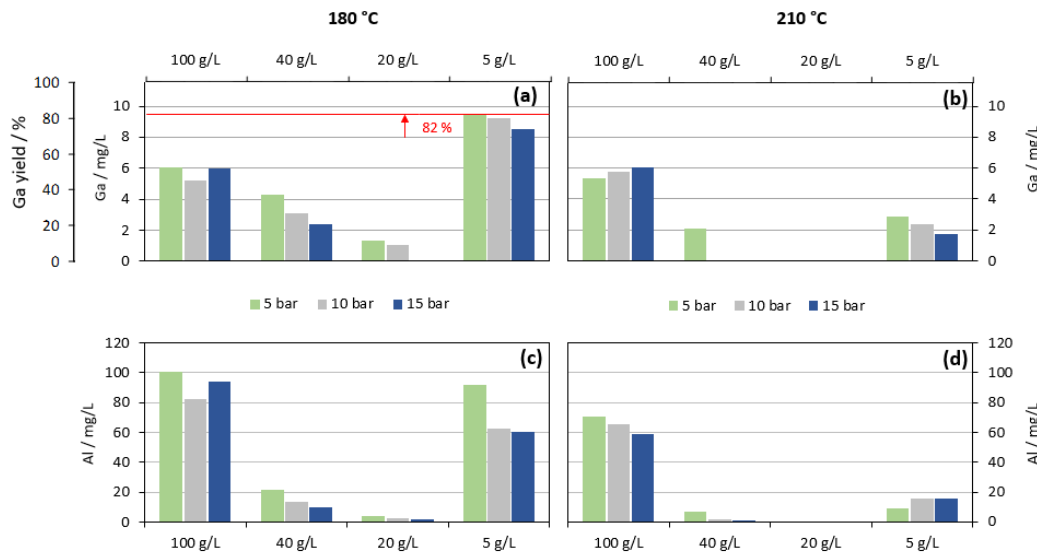
Figure 9. The gallium concentration in the liquor and max. yield at 180 °C ( a ) and 210 °C ( b ); the aluminum concentration in the liquor at 180 °C ( c ) and 210 °C ( d ); constants: 1 h, 800 rpm, S/L: